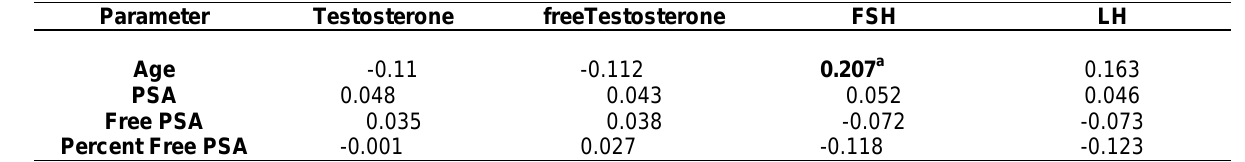
Correlations Between Clinical and Endocrinological